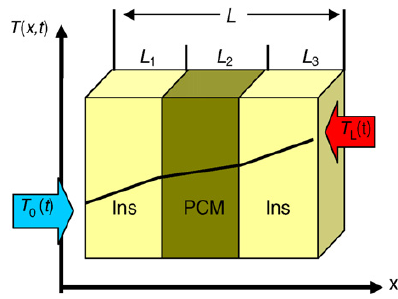
Figure 3. Typical temperature distribution for exiting the one ‐ phase solid sub ‐ routine.